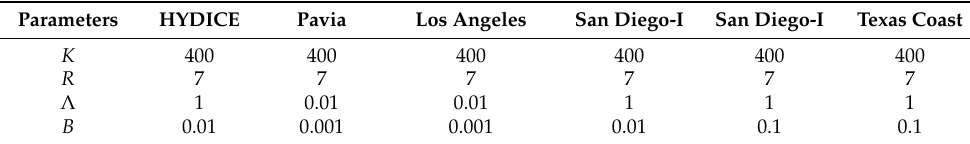
Table 1. Optimal parameters settings for experimental datasets.